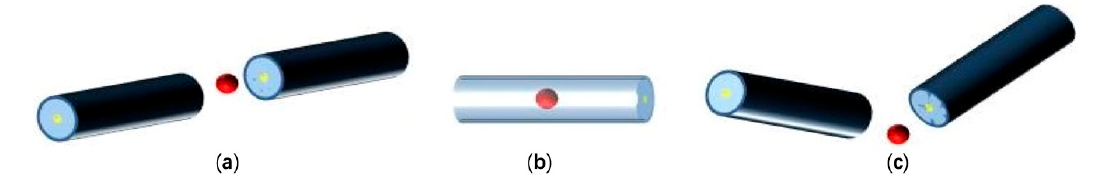
Figure 4. Optical trapping micro-objects based on a dual-beam fiber trap. ( a ) Aligned fibers; ( b ) Hollow-core photonic crystal fiber; ( c ) Inclined fibers.